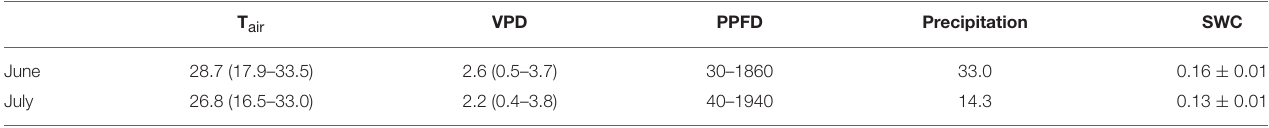
TABLE 1 | Average air temperature ( ◦ C), vapor pressure deficit (kPa) during the sampling campaigns with maximum and minimum values in brackets and range of photosynthetically active photon flux density ( µ mol m − 2 s − 1 ) during the BVOC